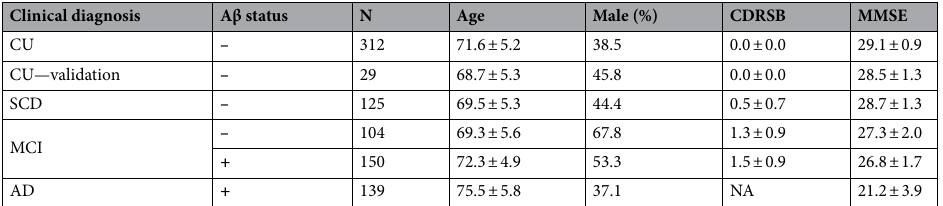
Table 1. Cohort demographics. All continuous values are reported as mean and standard deviation. Amyloid status was measured using the CSF Aβ42/40 ratio. The Aβ- CU group was used to fit the